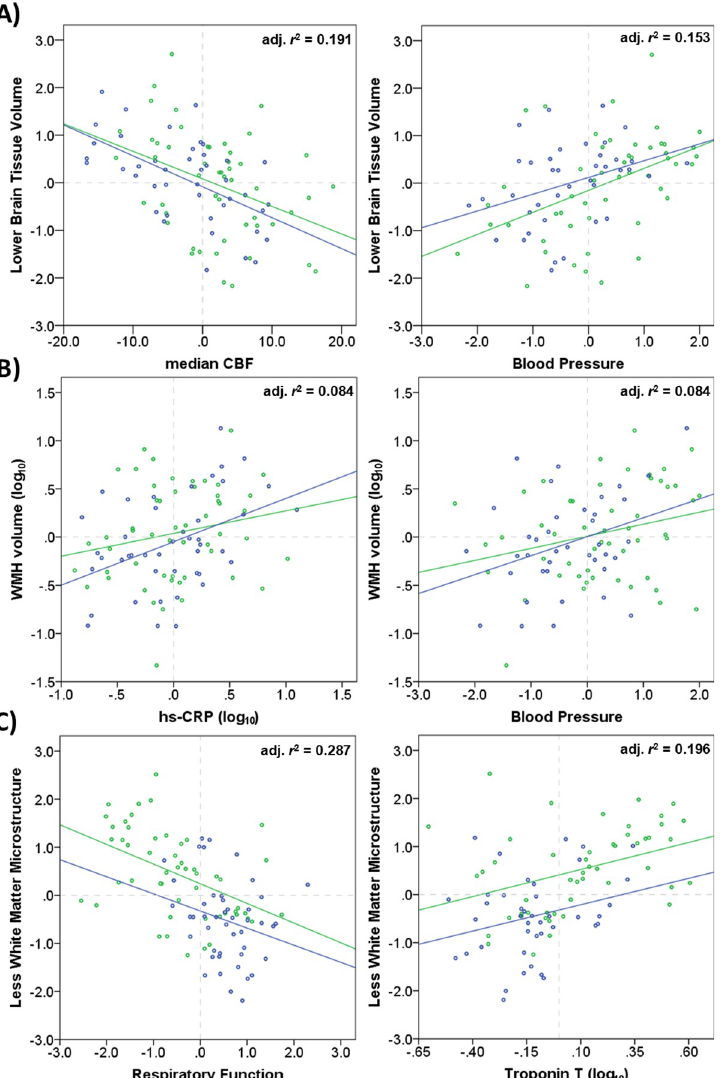
Fig 2. Relationships between brain structure and other disease markers. Plots showing the relationship between: Brain Tissue Volume, median CBF and Blood Pressure (panel A); WMH volume, hs-CRP and Blood Pressure (panel B); and White Matter Microstructure, Respiratory Function and troponin T (panel C) for COPD (green) and CAD (blue) patients. The adjusted r 2 goodness of fit is presented for the whole cohort. Data has been adjusted for age and sex. CBF = cerebral blood flow, hs-CRP = high-sensitivity C-Reactive Protein, WMH = white matter hyperintense lesion.